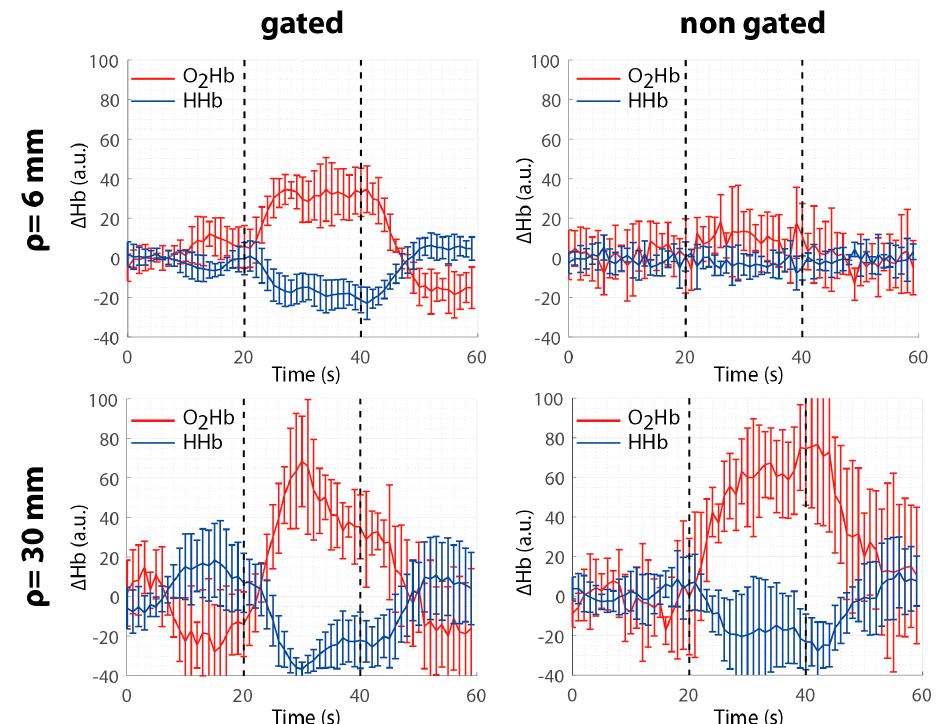
Figure 4. In vivo measurements of subject 2. Changes in O 2 Hb (red) and HHb (blue) averaged over the five repetitions of finger tapping with the contralateral hand for the gated and non-gated approach (left and right column, respectively) at the short and long distance (upper and bottom lines, respectively). Error bars represent the standard deviation over the five repetitions.